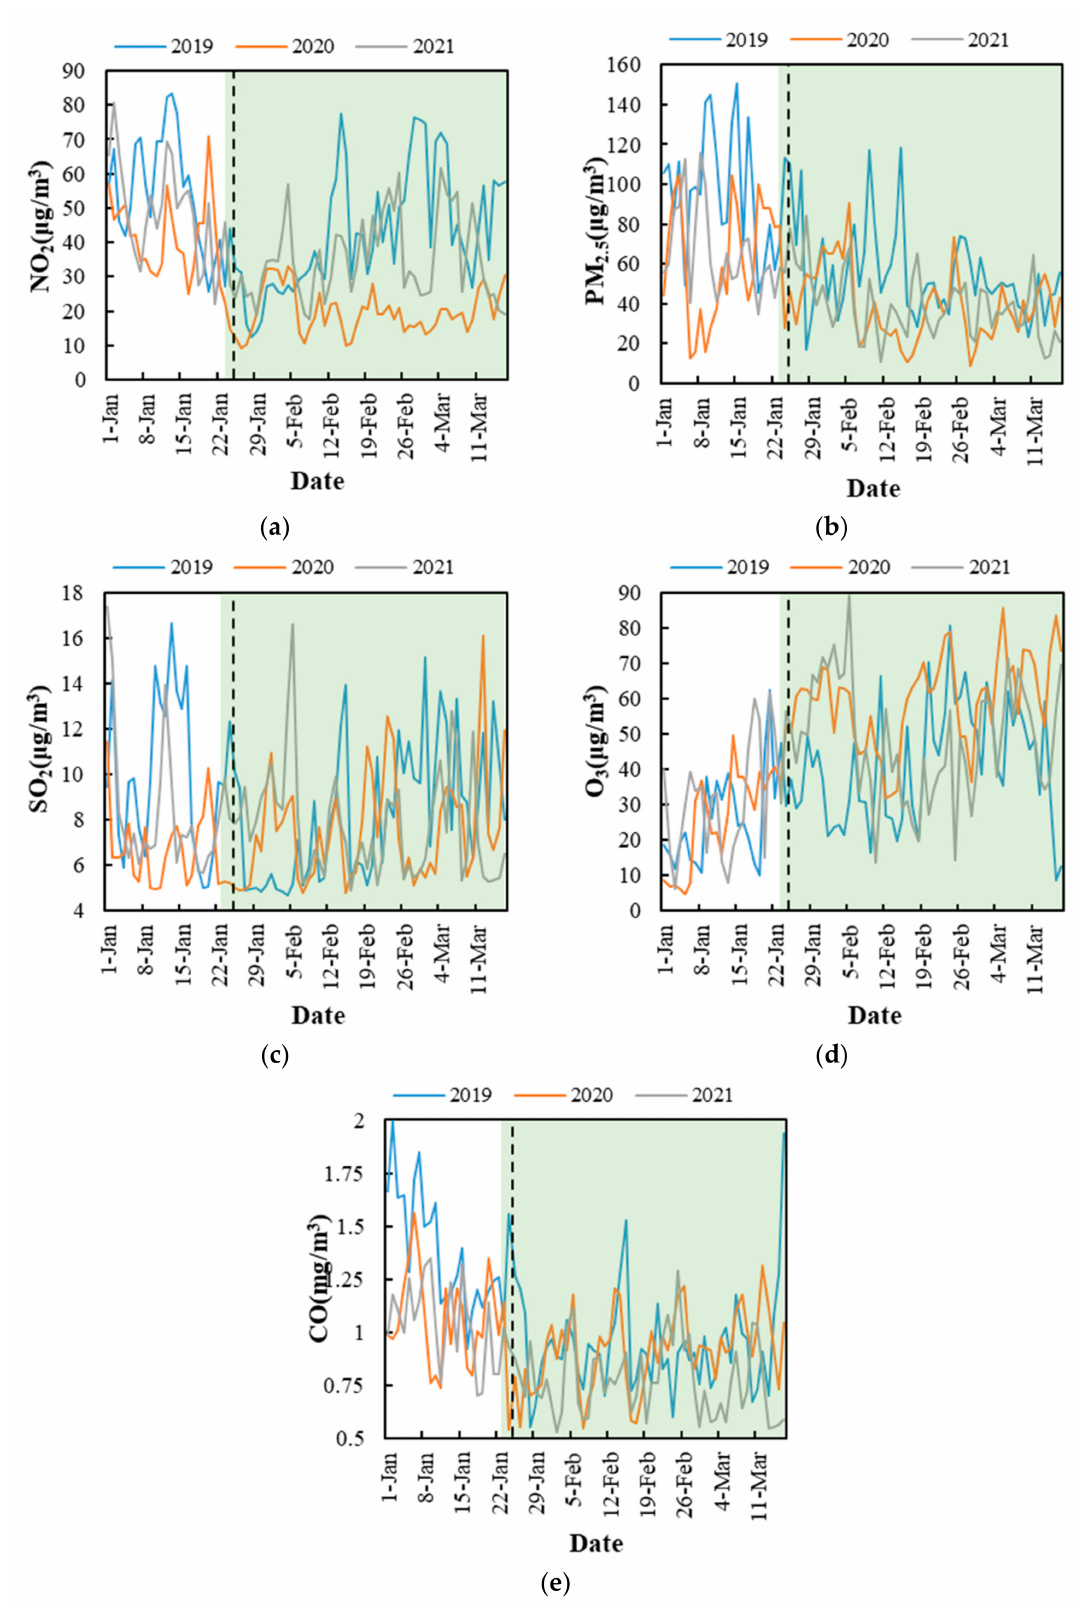
Figure 3. Observed changes in air pollutants over three years: ( a ) NO 2 ; ( b ) PM 2.5 ; ( c ) SO 2 ; ( d ) O 3 ; ( e ) CO (The black dashed vertical line means the date of the Spring Festival and the green area means the lockdown period in our